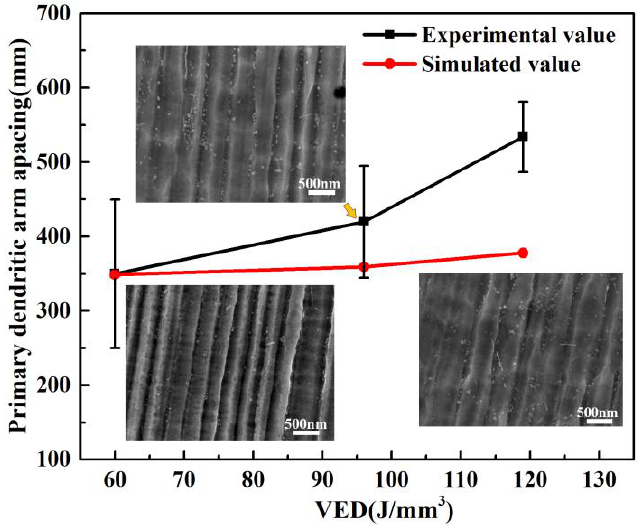
Figure 6. Relationship between VED and primary dendrite arm spacing.